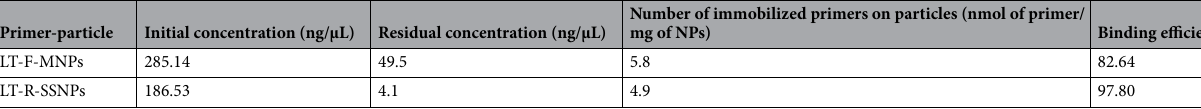
Table 2. Result of immobilization of LT-F onto the carboxylated MNPs and LT-R onto the SSNPs.